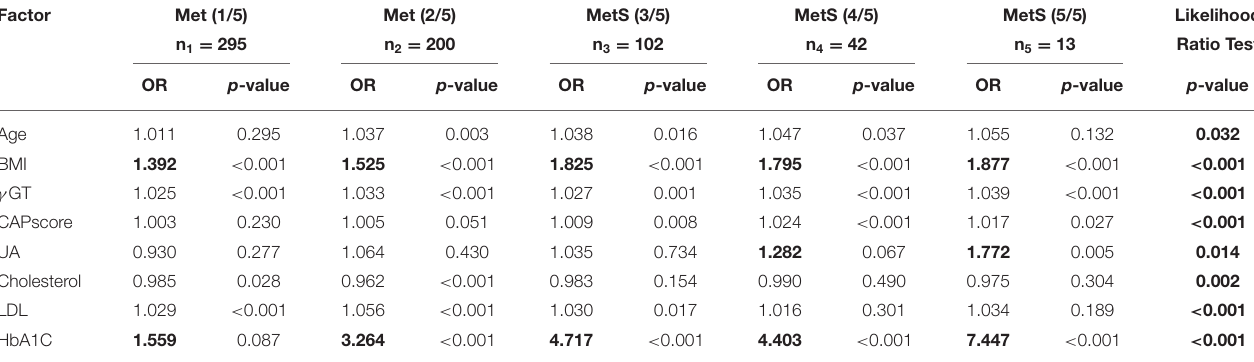
The baseline of multinomial logistic regression for the health group is (0/5) without any metabolic syndrome disorders. After stepwise regression, only eight factors were retained. High odds ratios are in bold.